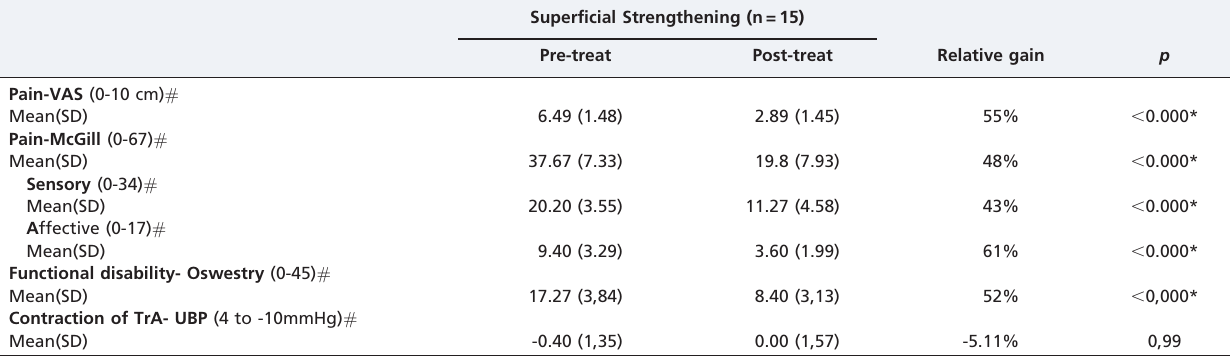
Table 4 - Pain, functional disability and contraction of TrA mean values of ST group at pre- and post-treatment evaluations, and p values.